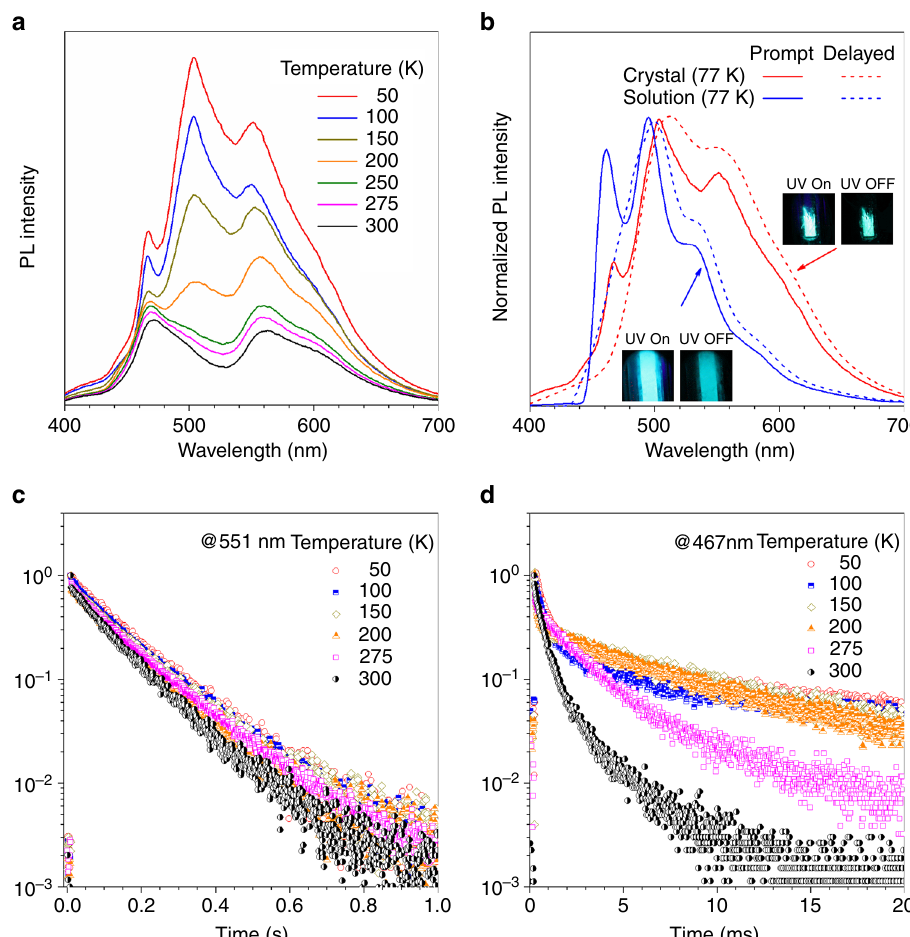
Fig. 3 Temperature-dependent photophyscial properties of ClBDBT. a PL spectra of ClBDBT crystals measured at different temperatures from 50 to 300 K. b The prompt ( solid line ) and delayed ( dash line , 10 ms) PL spectra and photos of ClBDBT crystals and solution (1 mM) in THF at 77 K. Inset : Photos of crystal and solution of ClBDBT taken at 77 K before and after removal of the UV excitation source. c , d Time-resolved PL decay curves of ClBDBT measured at c 551 nm and d 467 nm from 50 to 300